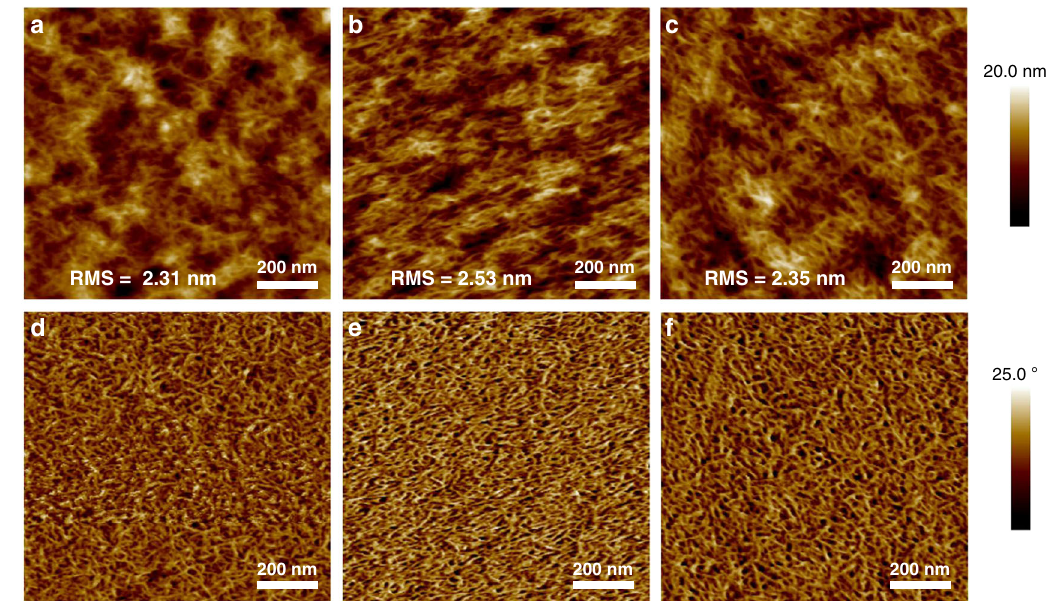
Fig. 3 AFM topography images of SD and BC blend fi lms. a, d SD (as-cast) fi lm. b, e SD (optimum) fi lm. c, f BC (optimum) fi lm. a 2.0